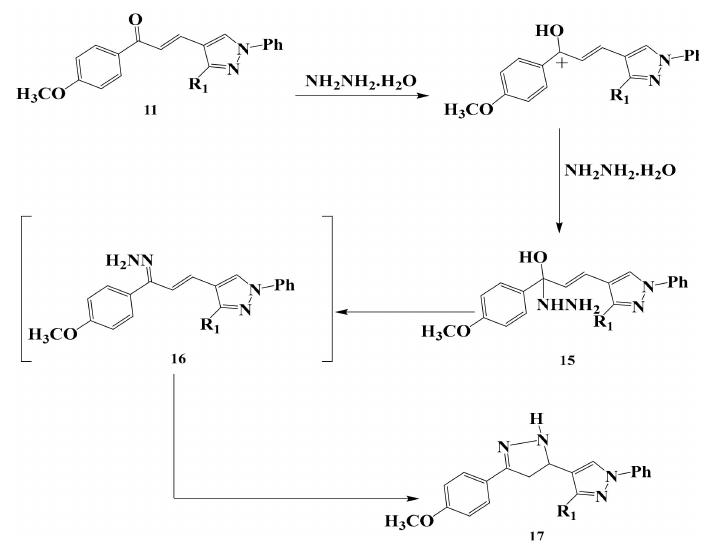
Scheme 6. The reaction mechanism of chalcone 11 with hydrazine hydrate to form pyrazole derivative 17